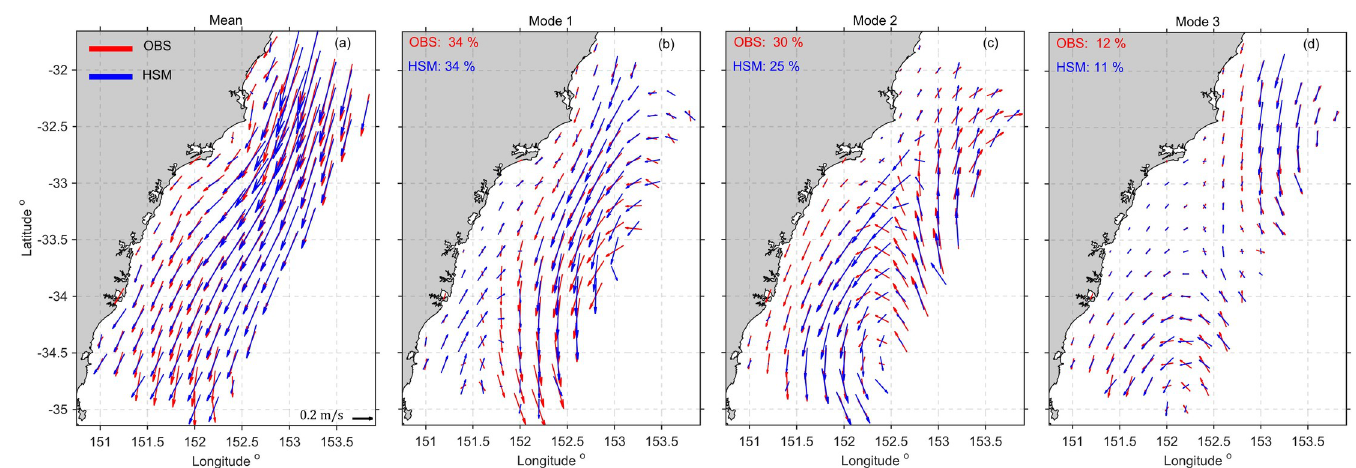
Fig 3. EOF analysis of daily geostrophic velocities from the HSM (blue) and satellite (red) for 2012–2013. Spatial structure of the (a) Mean, (b) Mode 1, (c) Mode 2 and (d) Mode 3 showing velocity fields (arrows). Percentages show the variances accounted for by each mode in the model and observations.